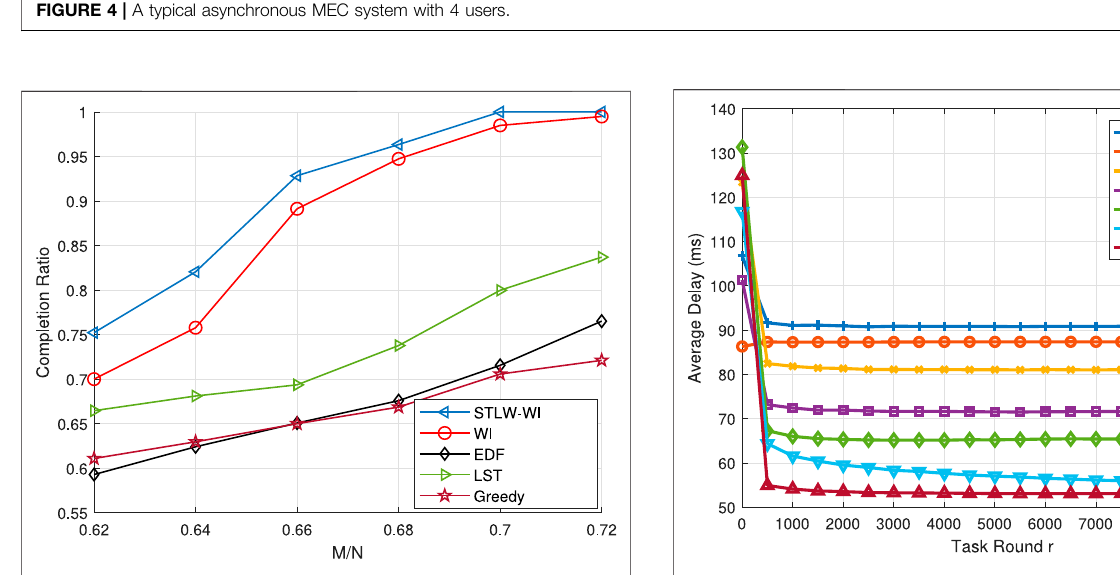
FIGURE 4 | A typical asynchronous MEC system with 4 users.